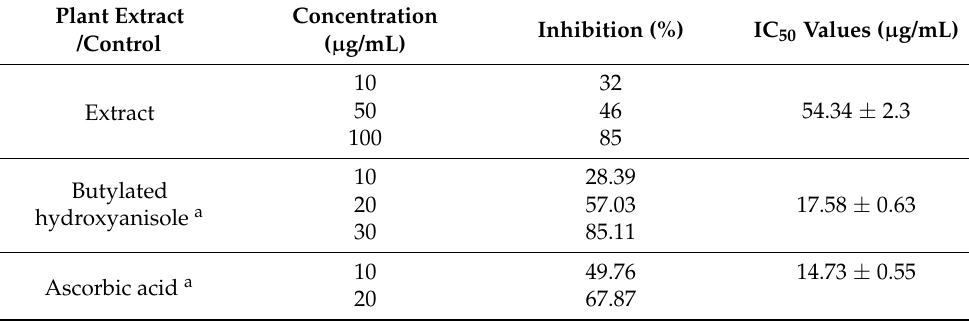
Table 3. Antioxidant activity of the methanolic extract from Pistacia lentiscus